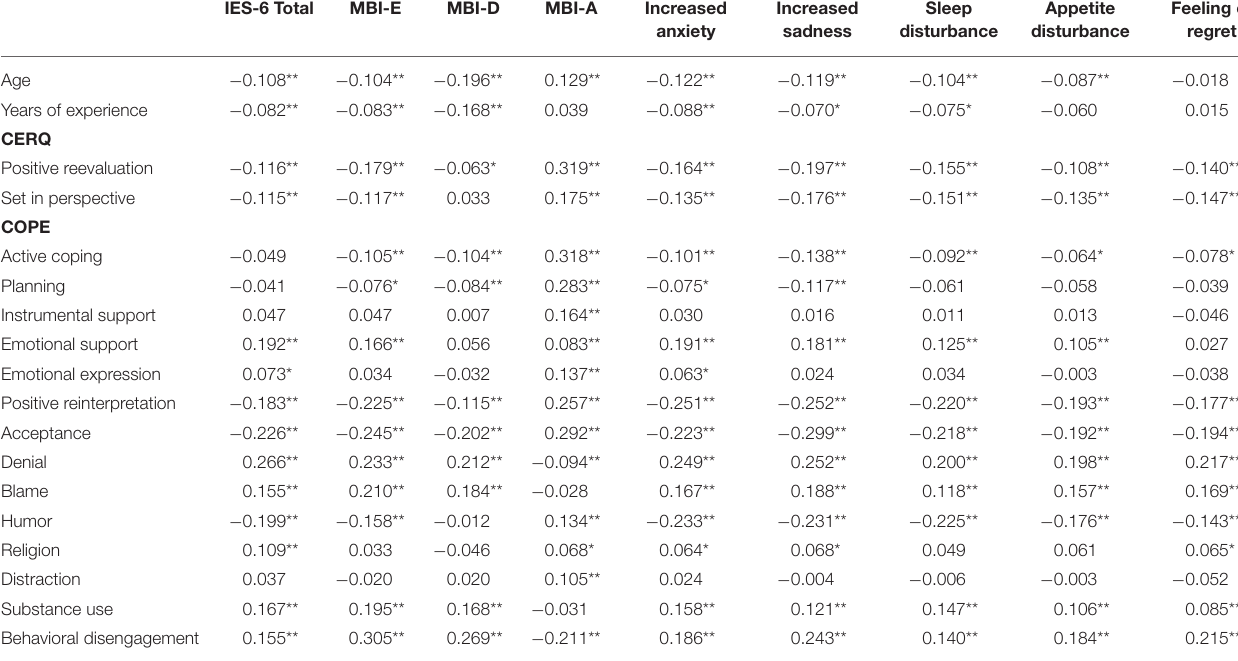
TABLE 2 | Correlational analysis.